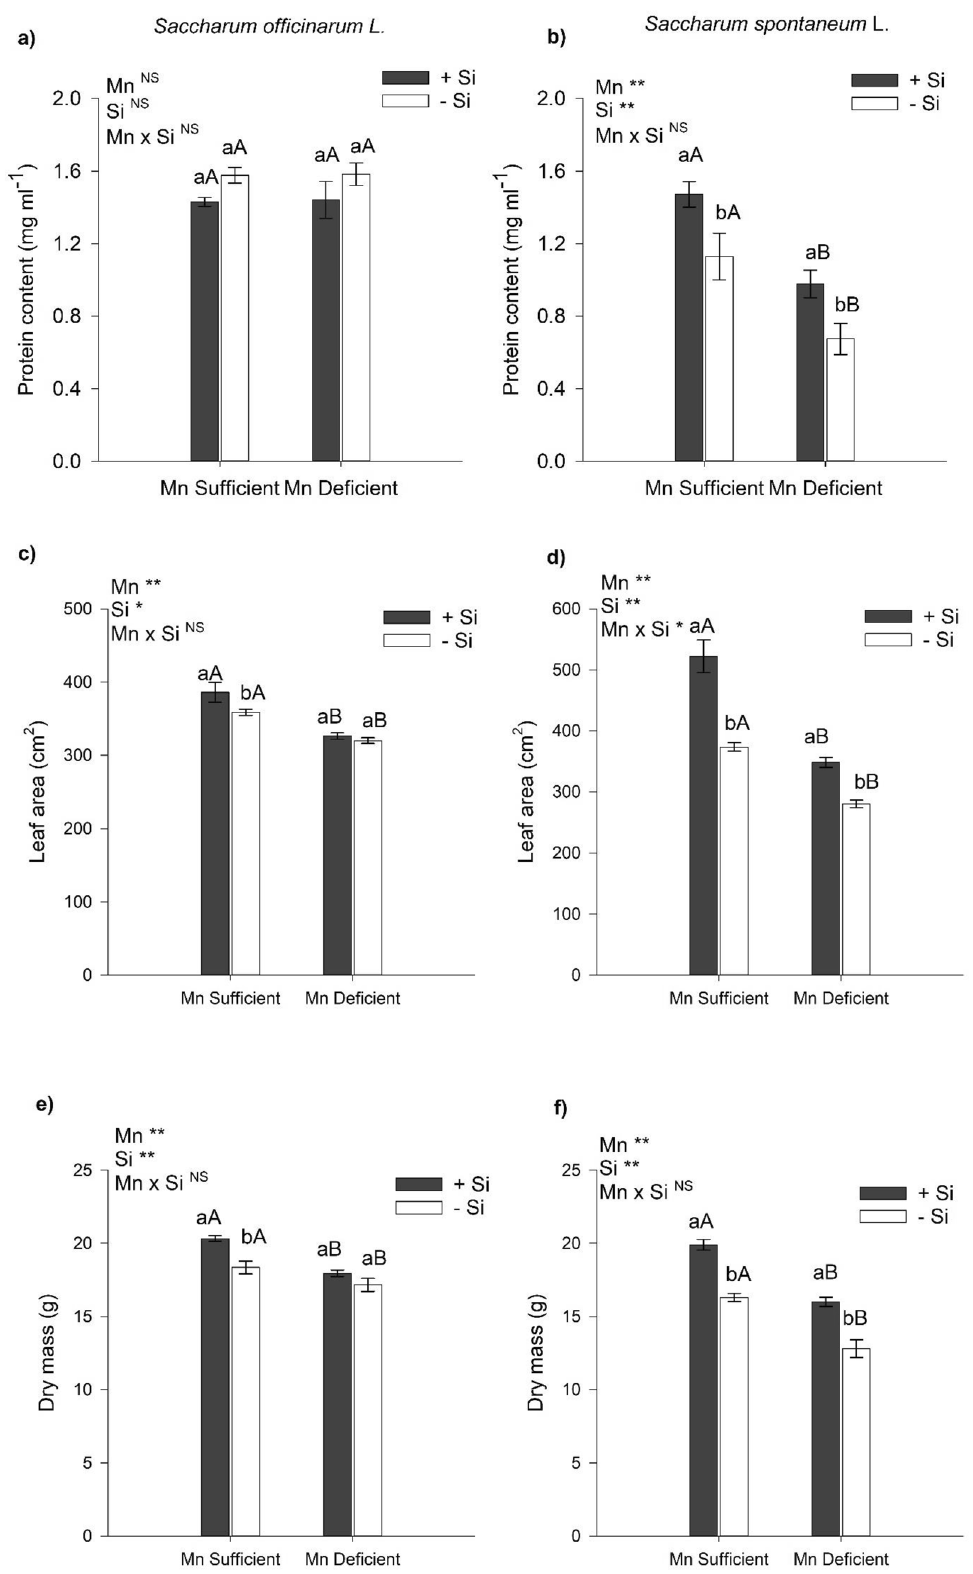
Figure 4. Protein content ( a , b ), leaf area ( c , d ), and total dry mass ( e , f ) of sugarcane ( Saccharum officinarum L.) and energy cane ( Saccharum spontaneum L.) plants, respectively, grown in Mn-sufficient and deficient nutrient solution in the absence (− Si) and presence (+ Si) of Si. F-test was applied: * ( p ≤ 0.05); **( p ≤ 0.01), and ns not significant. Different lowercase letters compare Si conditions under the same Mn condition ( p < 0.05 by Tukey test), while different uppercase letters compare Mn conditions under the same Si condition ( p < 0.05 by Tukey test). Bars represent the mean standard error, n =